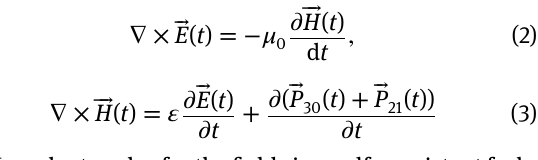
Figure2: Energyleveldiagramandparametersusedformodellingthe dye molecules in FDTD simulations. The transition energies are E E 3 − E 0 and E 21 = E 2 − E 1 . Since the transition from L 3 to L 2 is much faster than the transition from L ,leadingtoapopulationinversionforthetransitionfrom L to L 2 to the electromagnetic fields via the rate equations of the four-level system describing the gain medium [37].